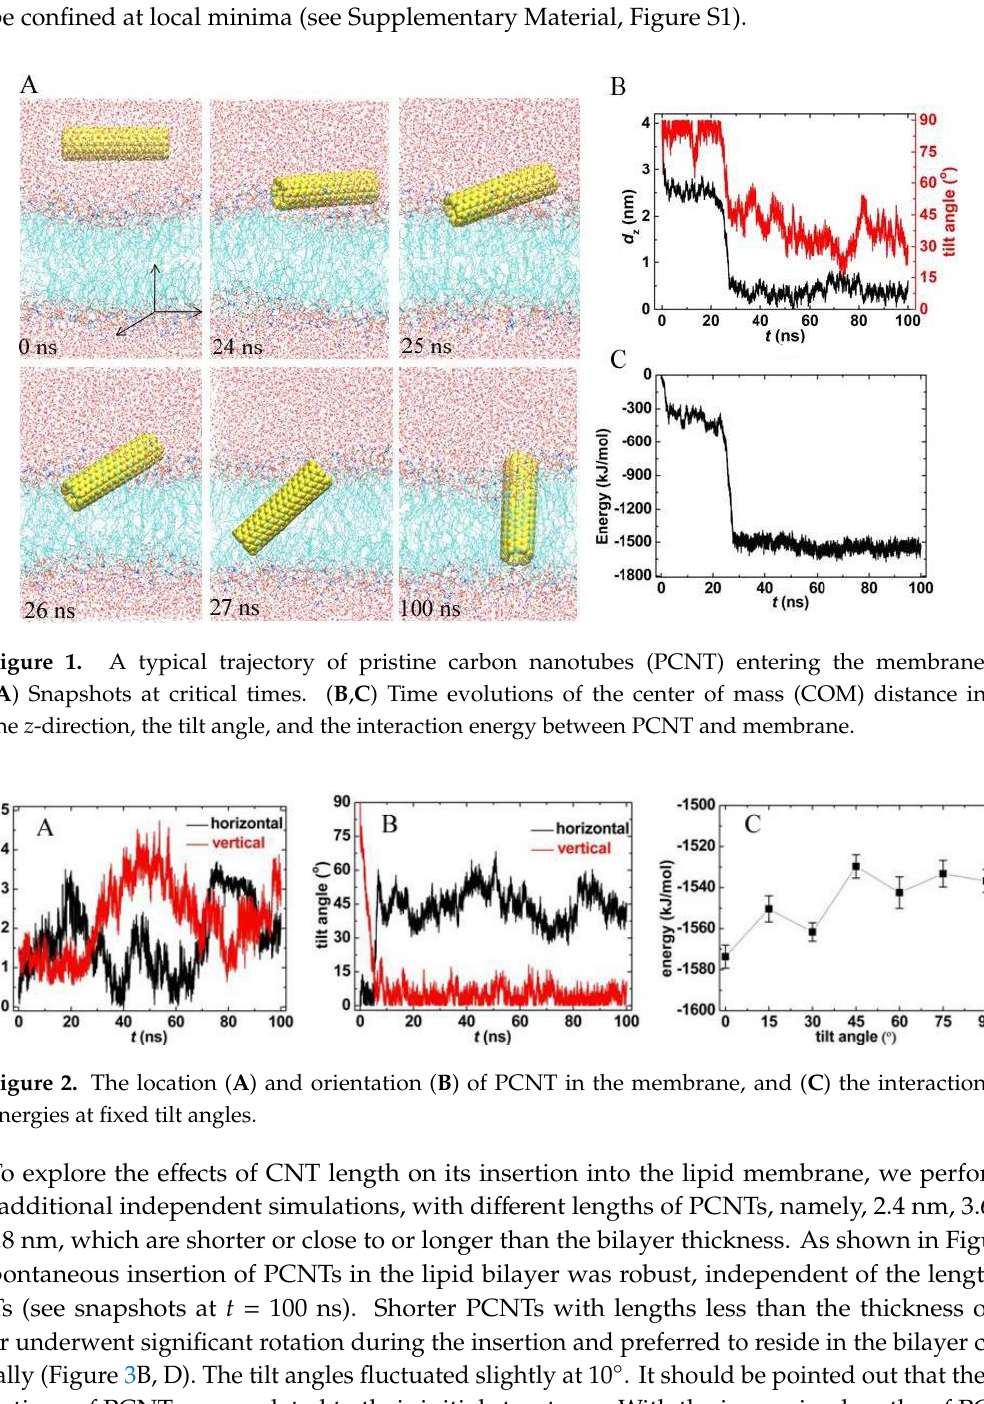
Figure 1. A typical trajectory of pristine carbon nanotubes (PCNT) entering the membrane. ( A ) Snapshots at critical times. ( B , C ) Time evolutions of the center of mass (COM) distance in the z -direction, the tilt angle, and the interaction energy between PCNT and membrane.